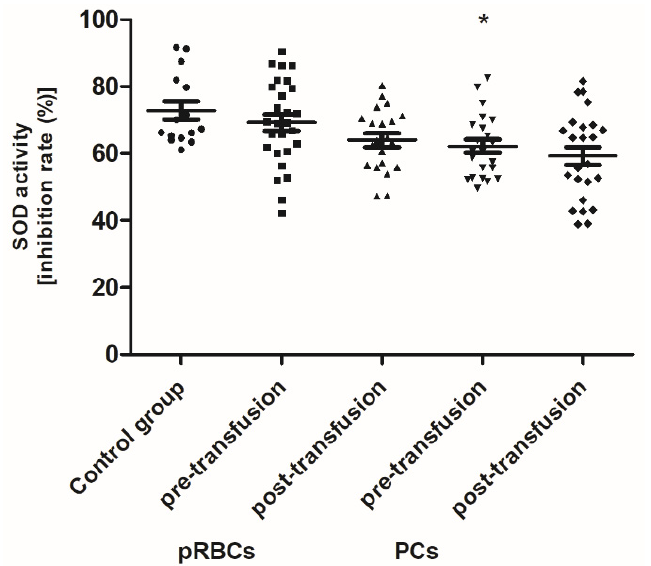
Figure 7. The activity of plasma SOD in healthy volunteers (control group) and AML patients before and after transfusion of the blood component. Scatter plots show all of the data values obtained. Data are presented as mean ± SE. * p < 0.05 compared to the control group; statistically significant according to the Tukey test. pRBCs—packed red blood cells; PCs—platelet concentrates.